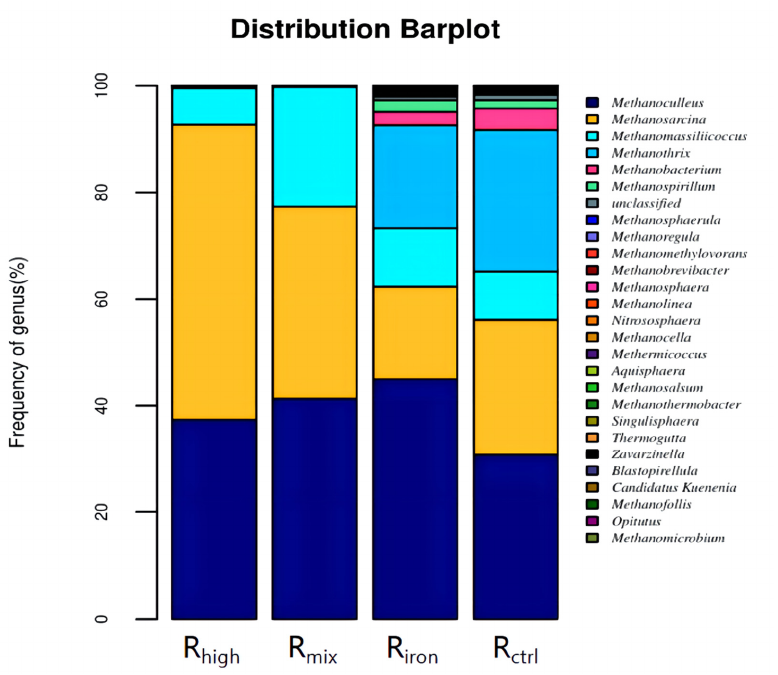
Figure 8. Archaeal communities at genus levels in four reactors.